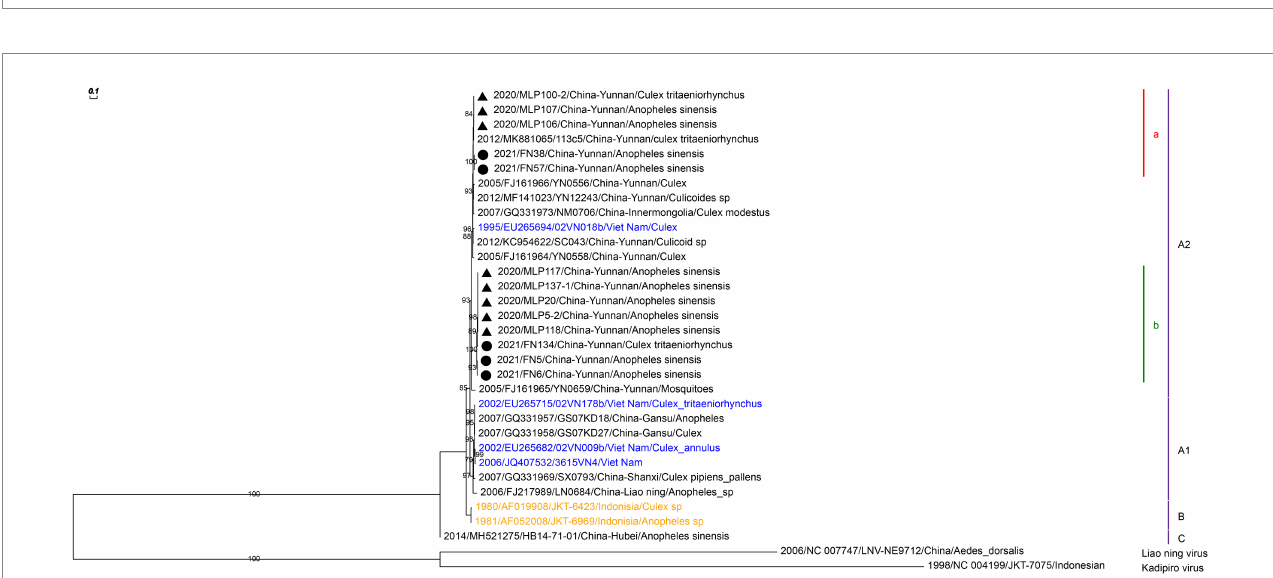
FIGURE 3 Phylogenetic analysis based on the nucleotide sequence of the partial 12th segment of BAV sequences (641 bp). The phylogenetic tree was constructed by the maximum likelihood statistical method using IQtree v2.2.0 software. Bootstrap values were obtained from 1,000 replicates. Each BAV sequence is denoted by year of isolation, GenBank accession number, strain, country of origin and isolation source. The sequences obtained from mosquitoes collected in Malipo county in this study are denoted by black triangle, and the sequences obtained from mosquitoes collected in Funing county in this study are denoted by black circle. Sequences from Vietnam and Indonesia are indicated in blue and orange, respectively. Different clades are marked with different colors on the right. Branch scale bars are shown as 0.01 substitutions per